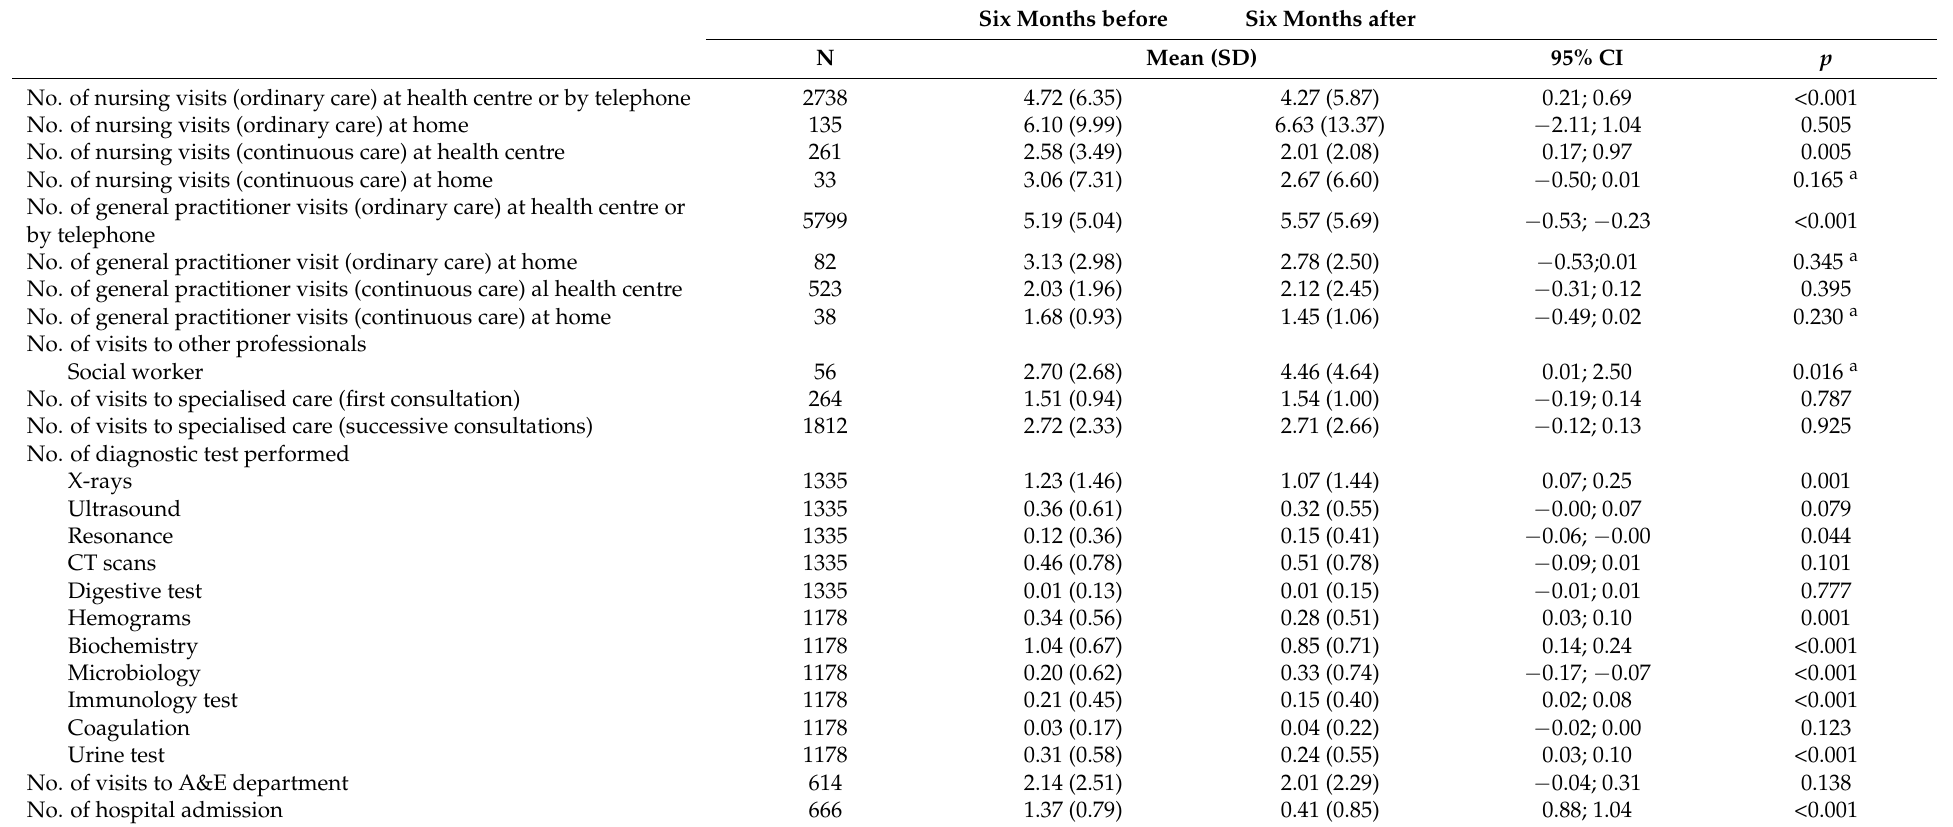
Table 4. Number of visits and diagnostic tests prescribed six months before and six months after